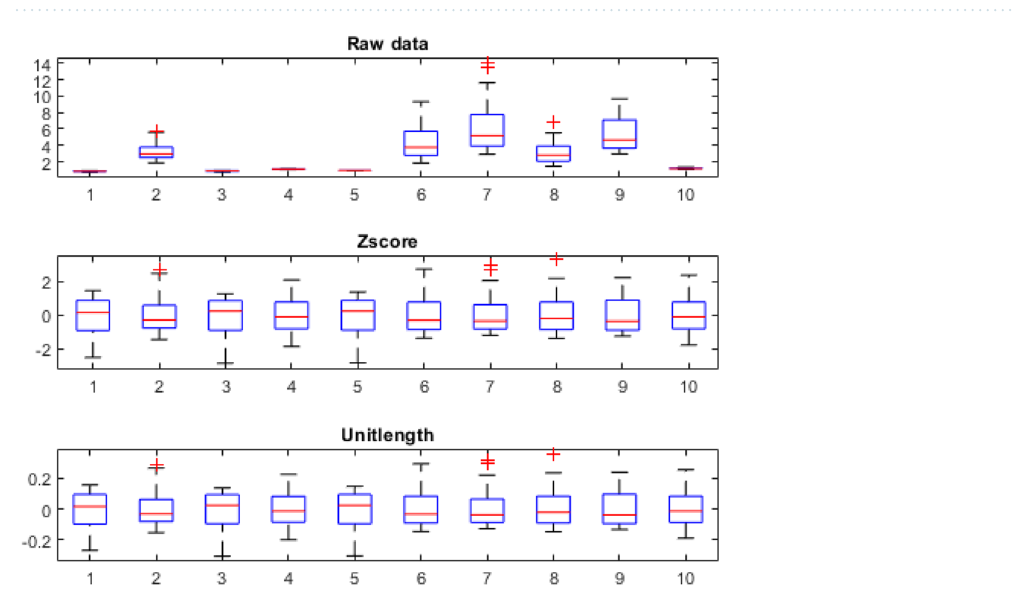
Figure 2. Data distributions after variable